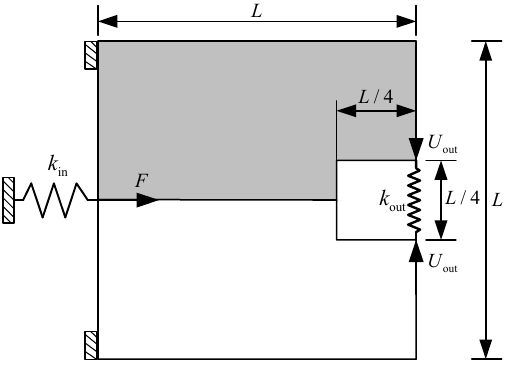
Figure 6. Design domain of compliant gripper.